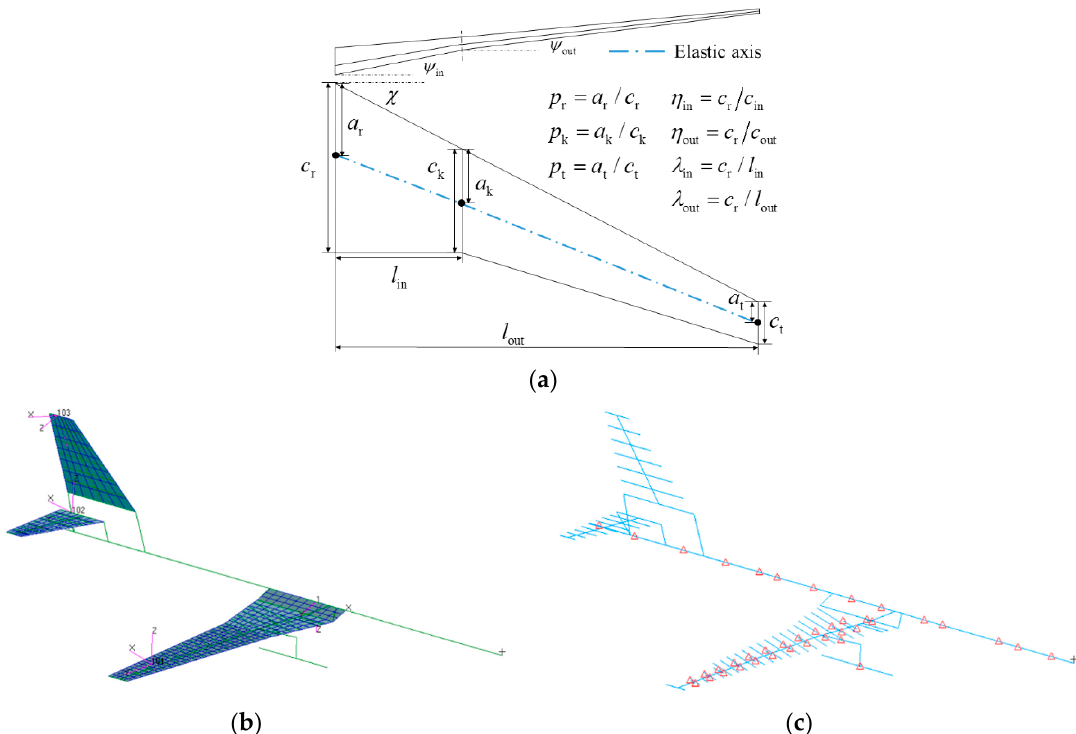
Figure 5. ( a ) A parametric wing structure; ( b ) lifting surface in the aerodynamic model; ( c ) model for structural